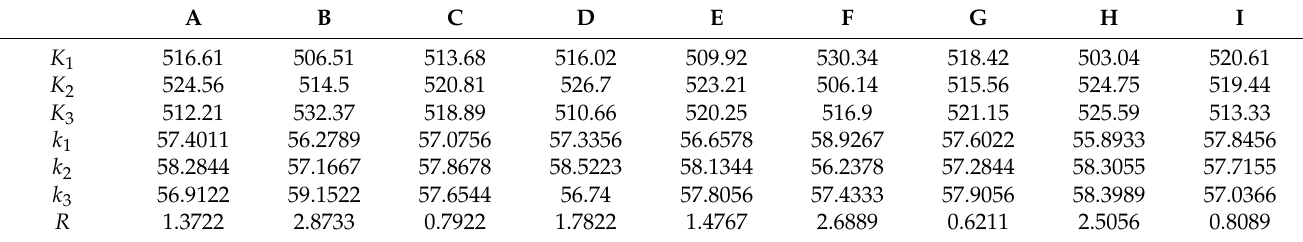
Table 8. Range analyses of simulated results.